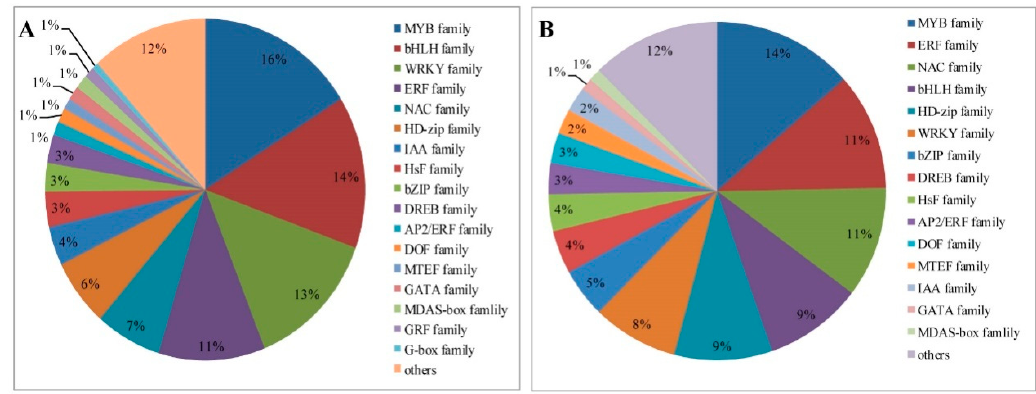
Figure 9. Distribution of common transcription factor families differentially expressed in foxtail millet under drought conditions. ( A ) Leaves. ( B ) Roots.